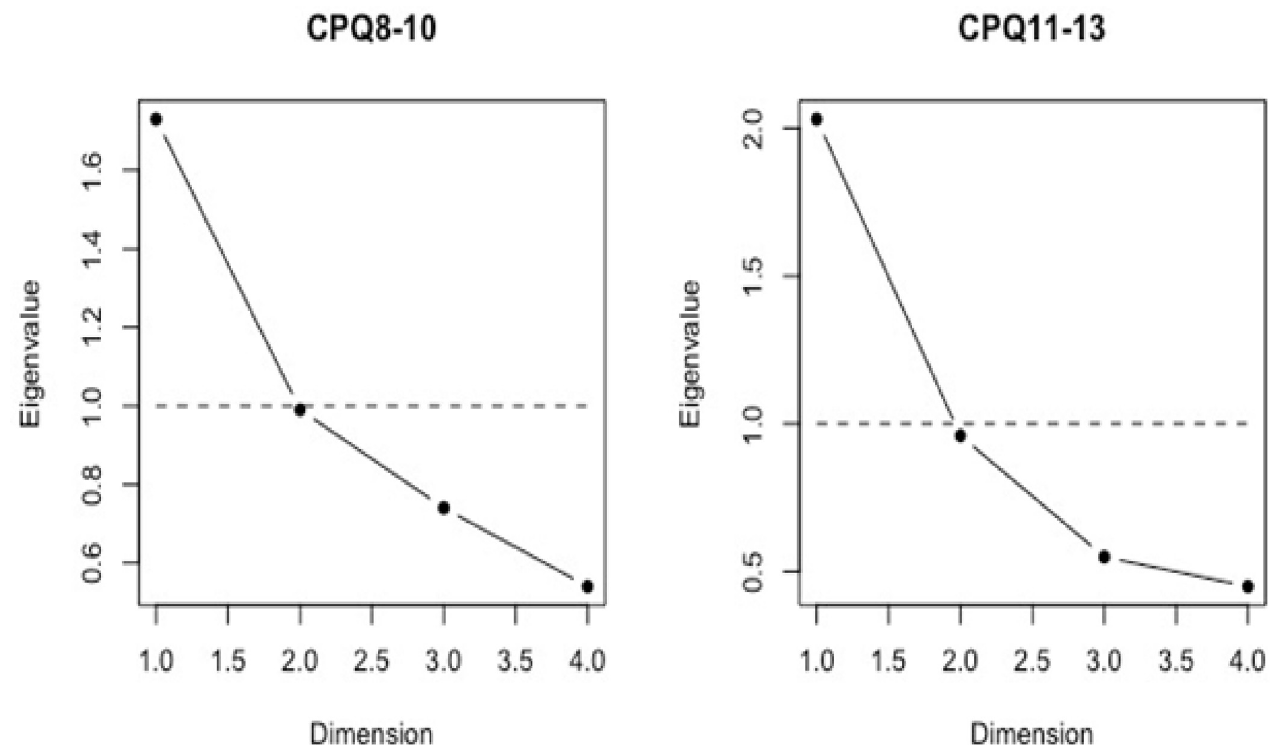
Fig 1. Scree plots of the 4-item CPQ 8-10 and CPQ 11-13 . https://doi.org/10.1371/journal.pone.0239449.g001 Table 4. Correlation between the 4-item, 8- and 25/31-item CPQ 8–10 and CPQ 11–1